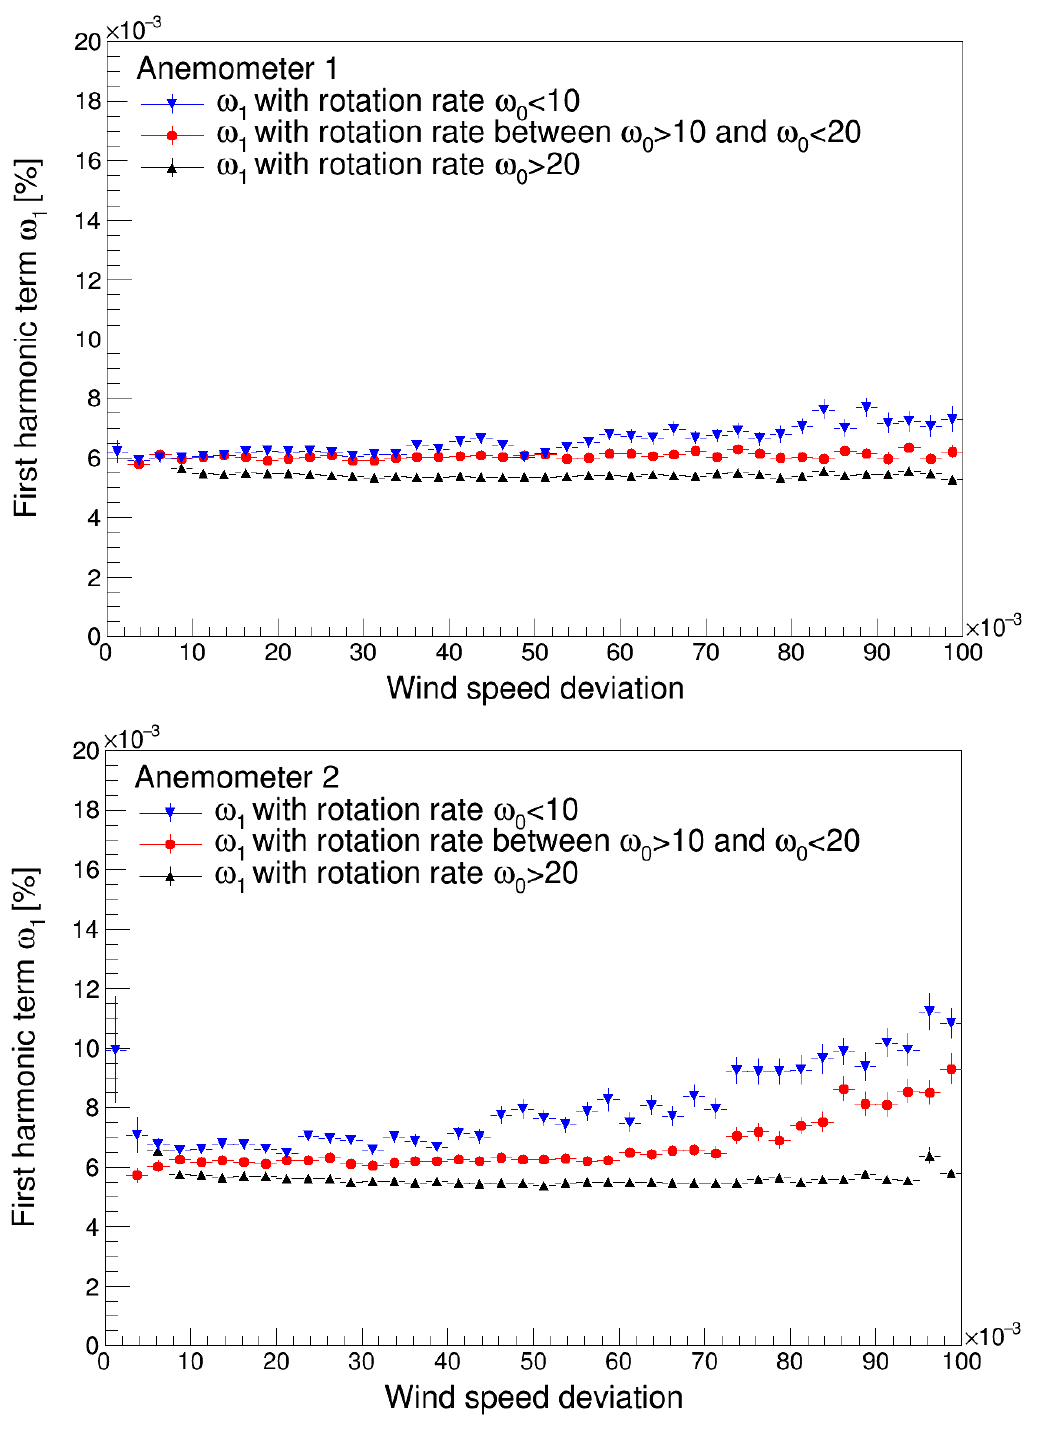
Figure 9. First harmonic terms of Anemometer 1 ( top ) and Anemometer 2 ( bottom ) as a function of the non-dimensional wind speed deviation.